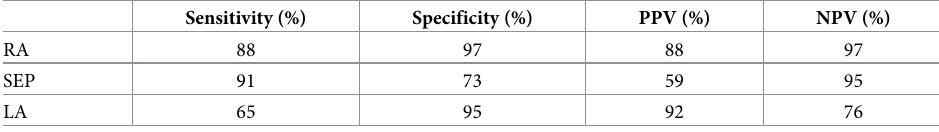
Table 3. Accuracy of the algorithm to differentiate the area of non-PV triggers.